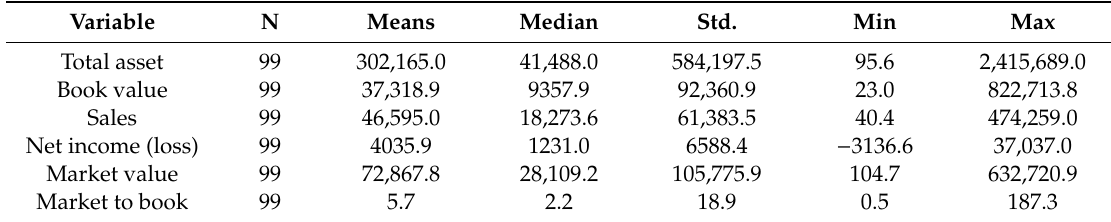
Table 4. Summary statistics (unit: million).